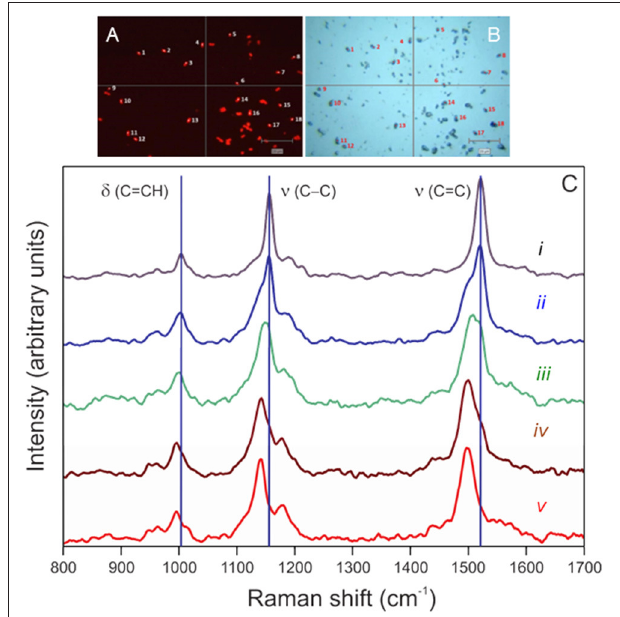
FIGURE 1 | Examples of resonance Raman spectra obtained from EUBMIX-hybridized (Cy3) Synechococcus sp. (RS9916) cells (0.5–1.8 µ m in diameter) pictured in fluorescence (Y3 ET, k—545 excitation/610 emission) (A) and bright-field (B) images. Cells manually targeted in the microscope